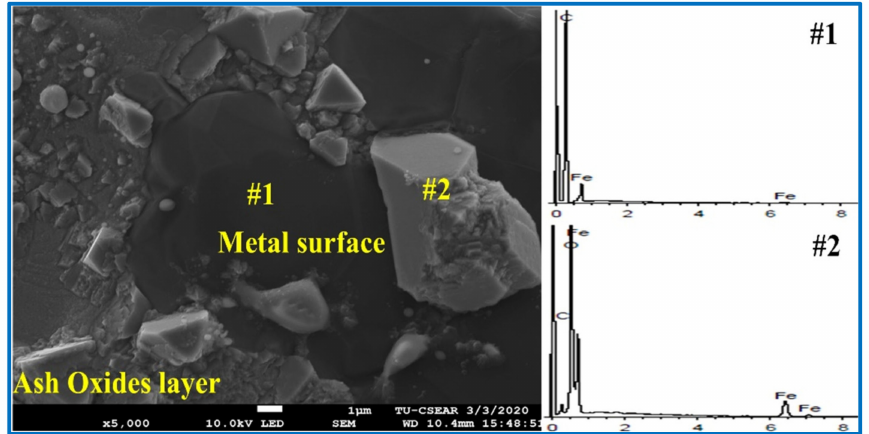
Figure 12. SEM micrograph ( × 5000) on the surface of the metallic Fe droplets obtained after high- temperature interaction of 30 min in the case of RTB#3. Table 9. EDS point analysis on the surface of the metallic Fe droplets obtained after high-temperature interaction of the CCP for 30 min in the case of coal, RTB#3, and RTB. Samples